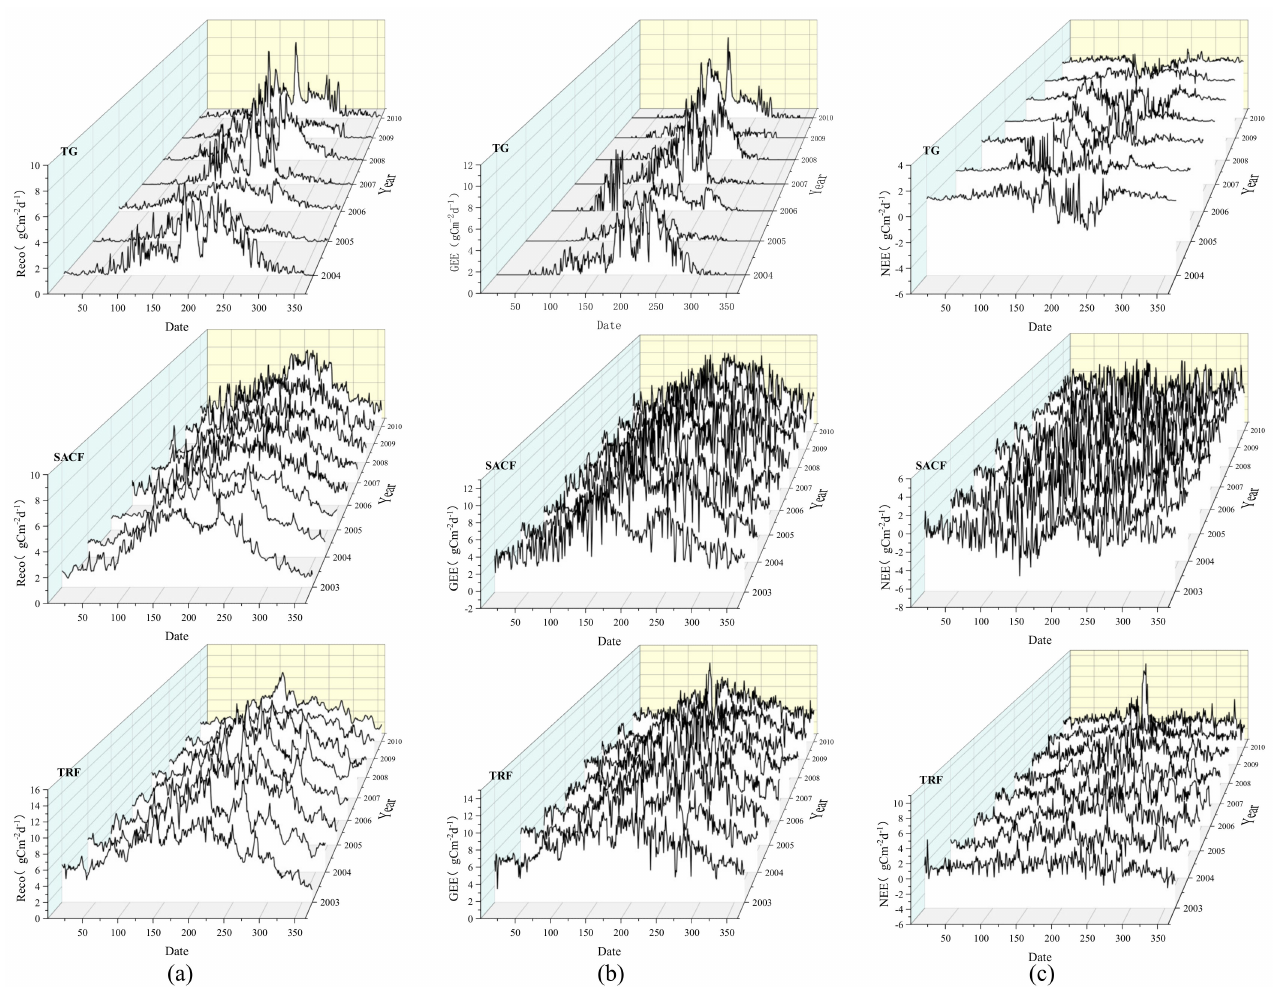
Figure 2. Inter − annual variation of ecosystem respiration ( a ), gross ecosystem exchange ( b ), and net ecosystem exchange ( c ) in temperate grassland (2004–2010), subtropical artificial coniferous forest (2003–2010), and tropical rain forest (2003–2010). Note: TG is temperate grassland, SACF is subtropical artificial coniferous forest, TRF is tropical rain